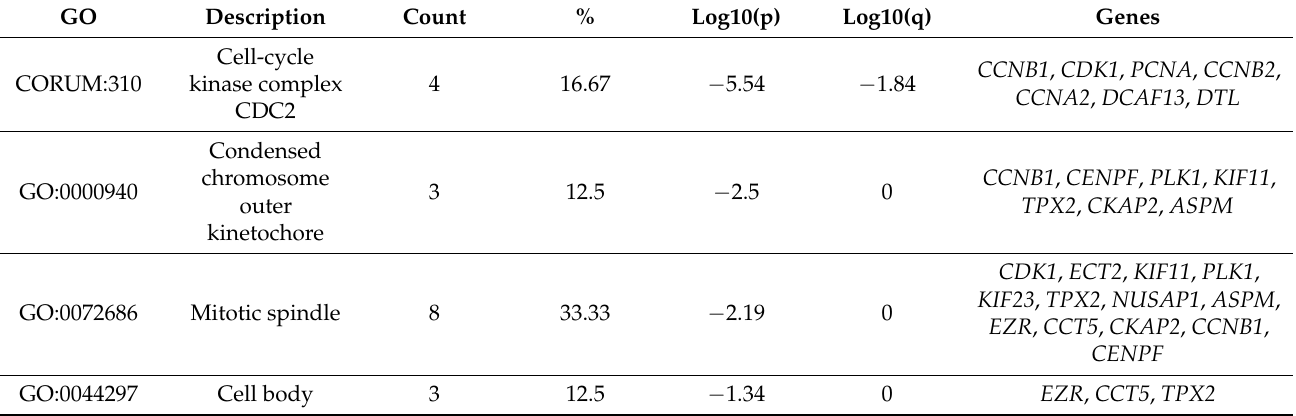
Table 2. Top 4 clusters with their representative enriched terms (one per cluster) from cellular components enrichment analysis. “Count” is the number of genes in the user-provided lists with membership in the given ontology term. “%” is the percentage of all of the user-provided genes that are found in the given ontology term (only input genes with at least one ontology term annotation are included in the calculation). “Log10(P)” is the p -value in log base 10. “Log10(q)” is the multi-test adjusted p -value in log base 10.